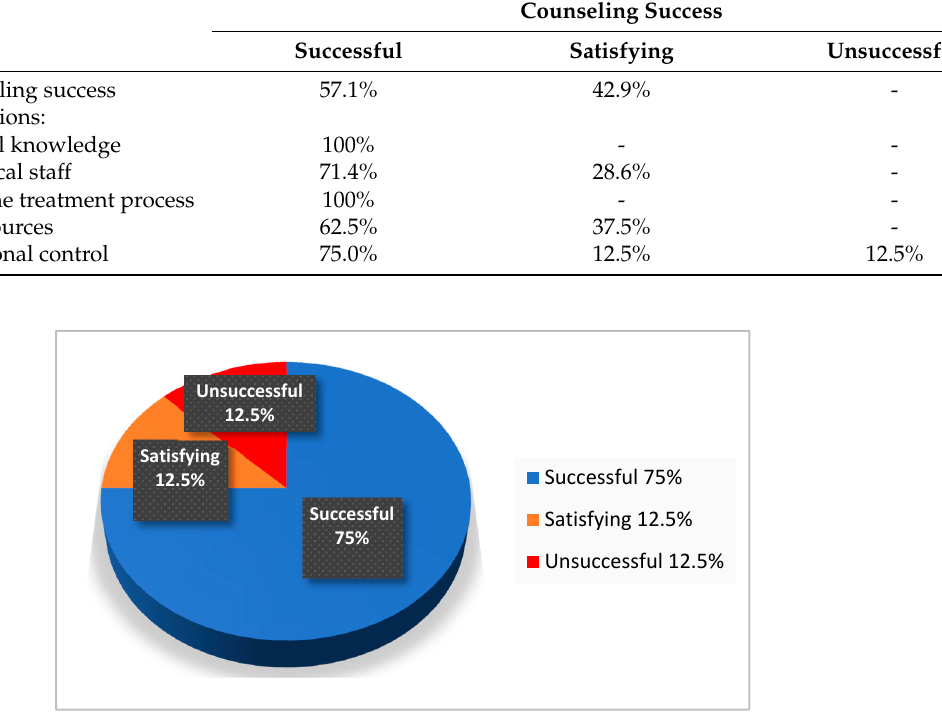
Figure 1. Distribution of counseling success (1. successful, 2. satisfying, 3. unsuccessful) for “parental perceived situational control” with regard to parental native language (i.e., parental native language differing from the language counseling was conducted in).